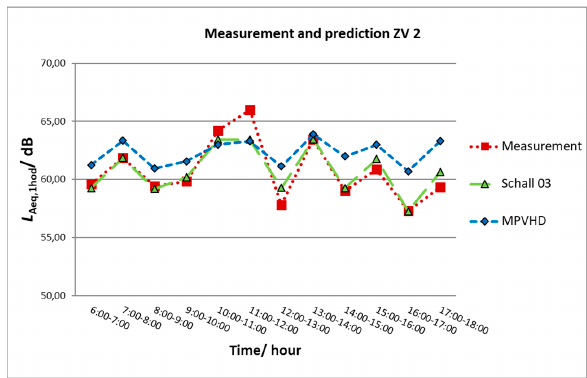
Figure 7. Graphical comparison of prediction and measurement of ZV2.